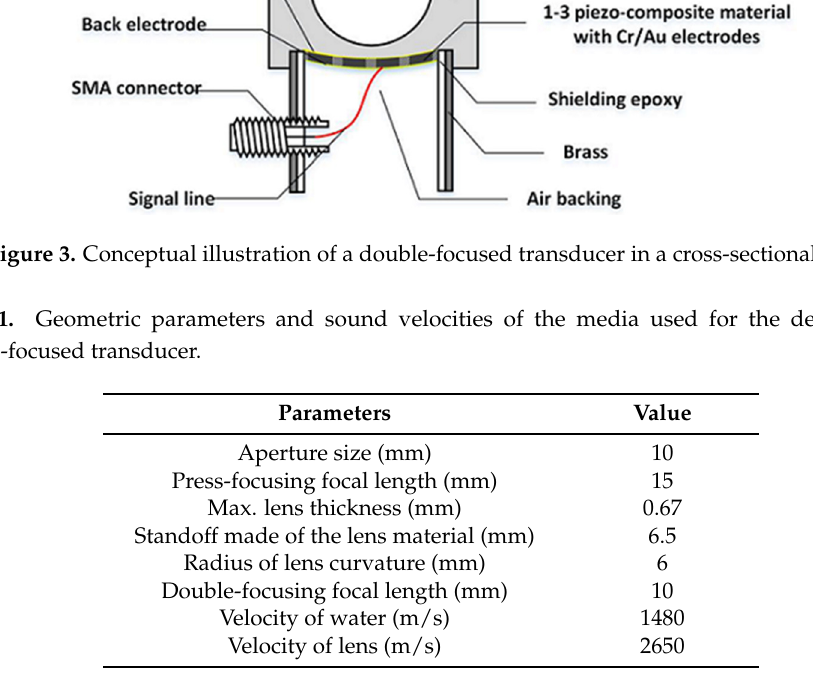
Table 2. Material properties of ceramic, kerf filler, lens, and 1-3 piezo-composite used for the double-focused transducer.